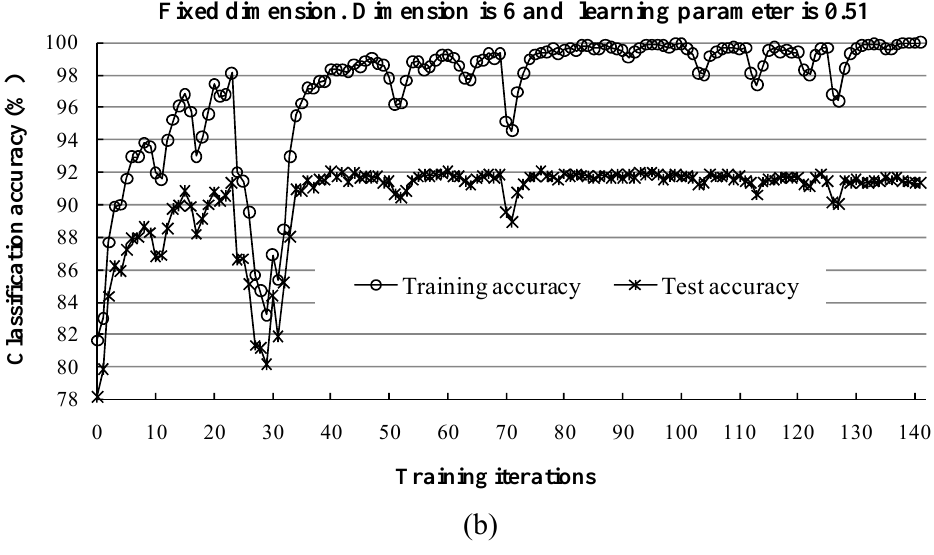
scores how the classification process has labeled a series of test sites or test pixels for which the correct land-cover label is known